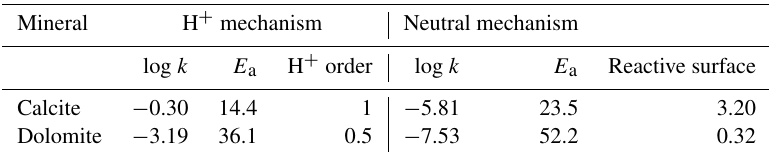
Table 1. Parameters for kinetic control for dissolution and precipitation of calcite and dolomite. k is given in molm − 2 s − 1 , E a in kJmol − 1 , − 1 . and reactive surface in m 2 kg H 2 O